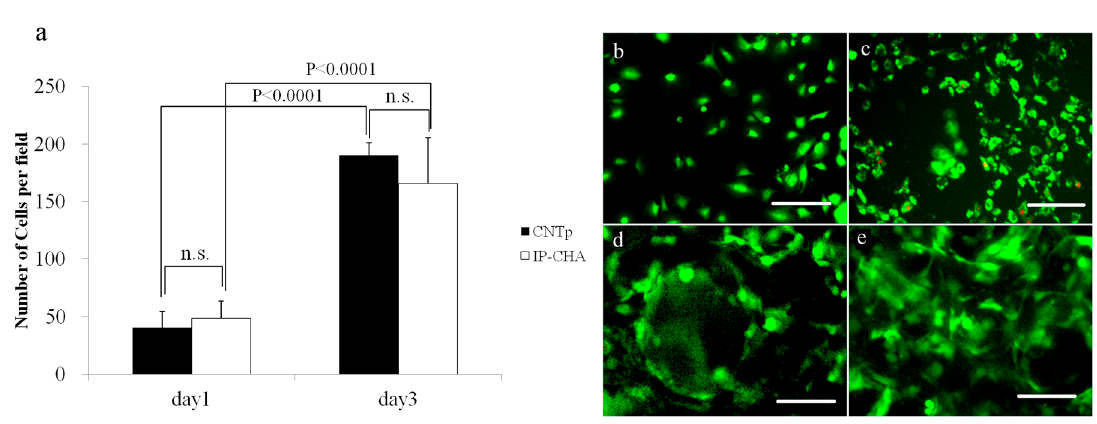
Figure 7. MC3T3 ‐ E1 cells spreading on IP ‐ CHA and CNTp scaffolds. Cells on ( a , c , e ) IP ‐ CHA or ( b , d , f ) CNTp. SEM images of ( a , c ) IP ‐ CHA and ( b , d ) CNTp. Original magnification is 2000× for ( a , b ) and 20,000× for ( c , d ). Cells labeled for actin filaments (red) and nucleus (blue) of ( e ) IP ‐ CHA and ( f ) CNTp.